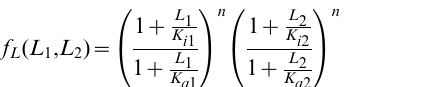
and K i 1 , K a 1 , K i 2 , K a 2 are the receptor’s affinities in the inactive and active states for the ligands L 1 and L 2 respectively. Similarly to the single ligand case, in the range where K i 1 vv L 1 vv K a 1 and K i 2 vv L 2 vv K a 2 , the activity dependence on both ligand levels